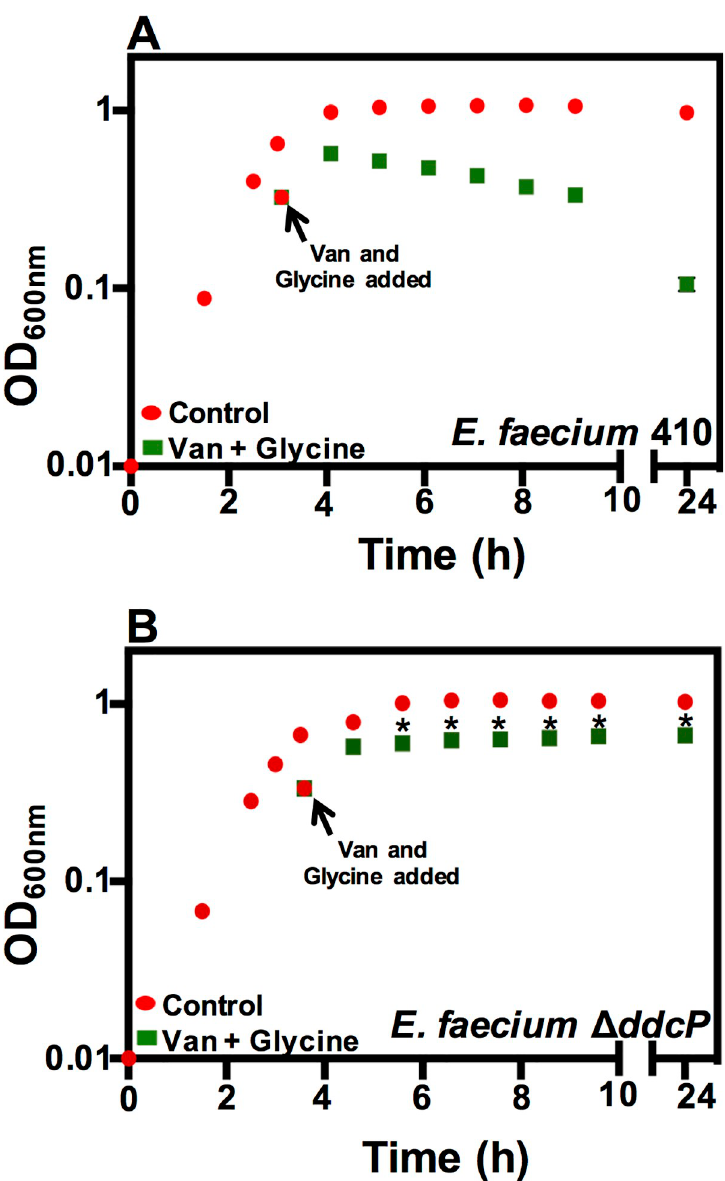
Fig 2. A Δ ddcP mutant has reduced susceptibility to vancomycin/glycine synergy. (A) E . faecium 410 wild-type and (B) ddcP deletion mutant cultures were grown at 37˚C in BHI until OD 600 reached 0.6 as described in materials and methods. Equal volumes of cultures were split into BHI (control; red circles) or BHI containing vancomycin (50 μ g/ ml) and glycine (0.2 M) (green squares). OD 600 values were monitored for 6 h and a reading at 24 h was recorded. Error bars indicate standard deviations from n = 3 independent experiments. Significance was assessed using the one- tailed Student’s t -test. � denotes P -value < 0.05. Stars indicate significant differences between vancomycin- and glycine-treated cultures in panel B versus